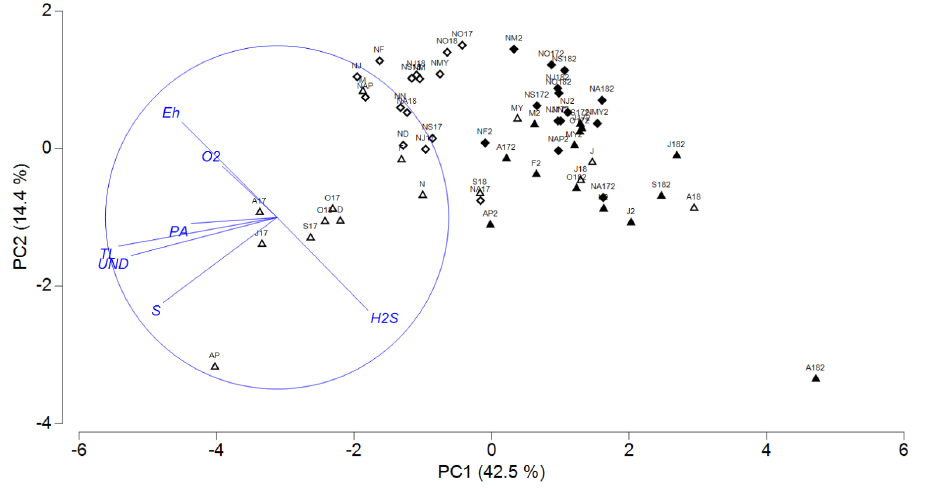
Figure 10. PCA plot of redox potential ( E h ), oxygen (O 2 ), hydrogen sulfide (H 2 S), sulfur (S), total lipid concentration (TL), prokaryotic abundance (PA) and unsaturation degree (UND) in the upper (0–4cm; , ) and lower (5–7cm; , ) layers of vegetated and nonvegetated sediments, respectively. Projections of variables are given in the